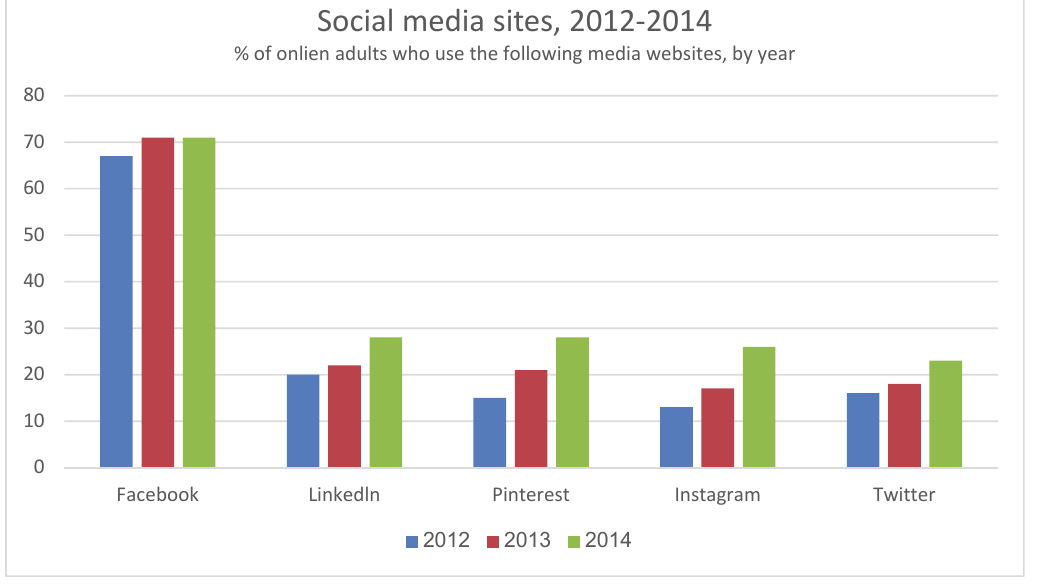
Fig. 1. Increase in use of